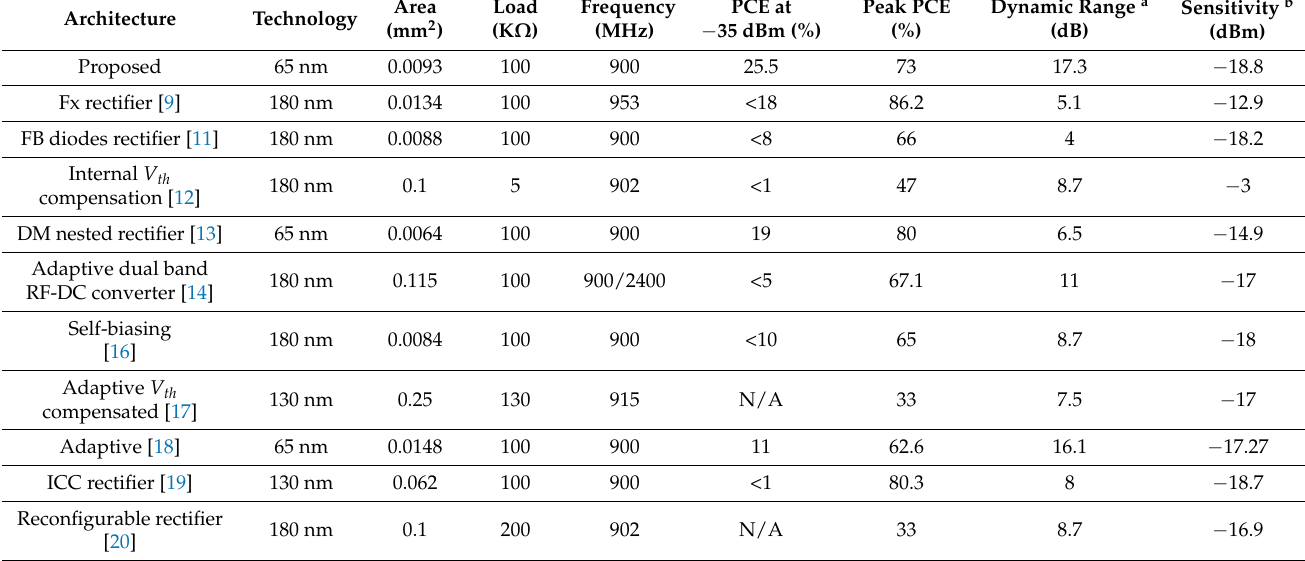
Table 1. Comparison with state-of-the-art RF CMOS rectifiers at the UHF Band.